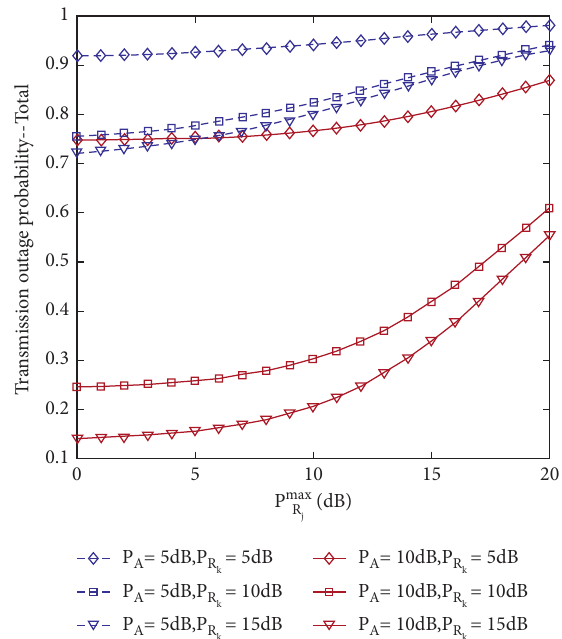
Figure 17: Total transmission outage probability versus P max R j with different different value of P R and P A , where σ 2 R � 0 dB , σ 2 B � 0 dB , R � 1 . 5, � 5, ε � 0 . 05, and σ 2 � 0dB. R B k � 3, and ϕ � 0 . 05. N R